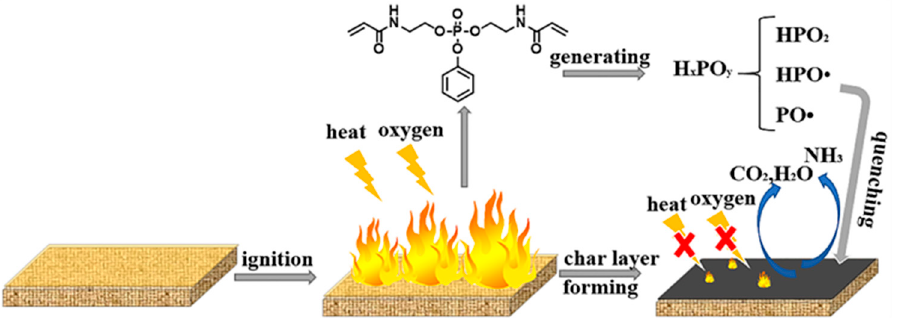
Figure 11. Flame-retardancy mechanism of the UV-cured coatings.